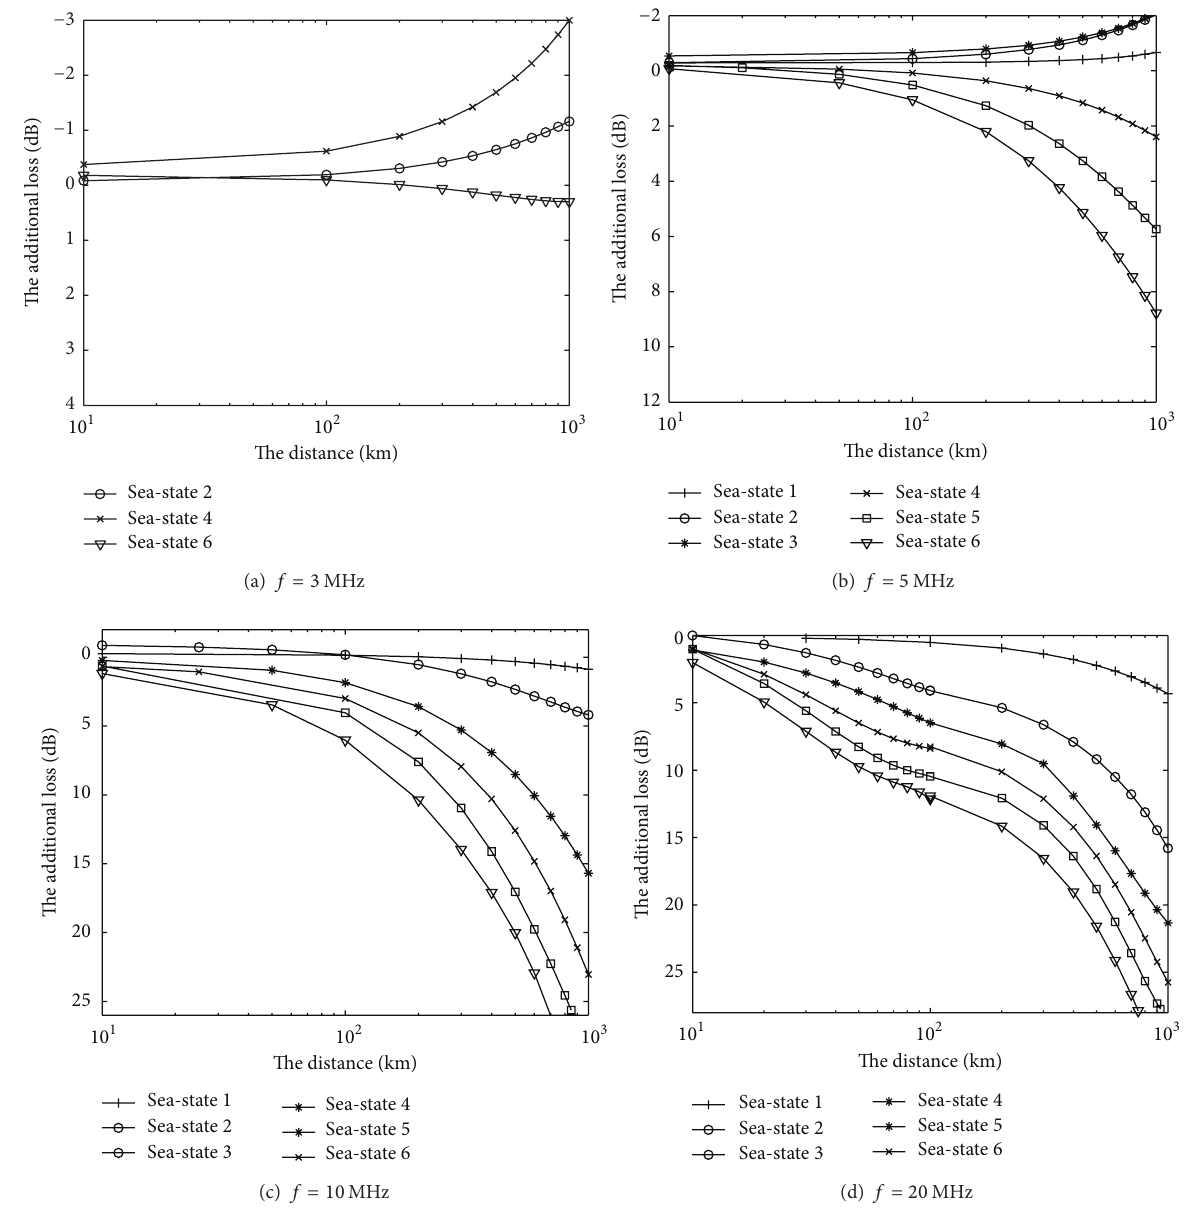
Figure 3: The curve of 𝐿 𝑤 with different sea states (S-T is sea state; W-V is wind